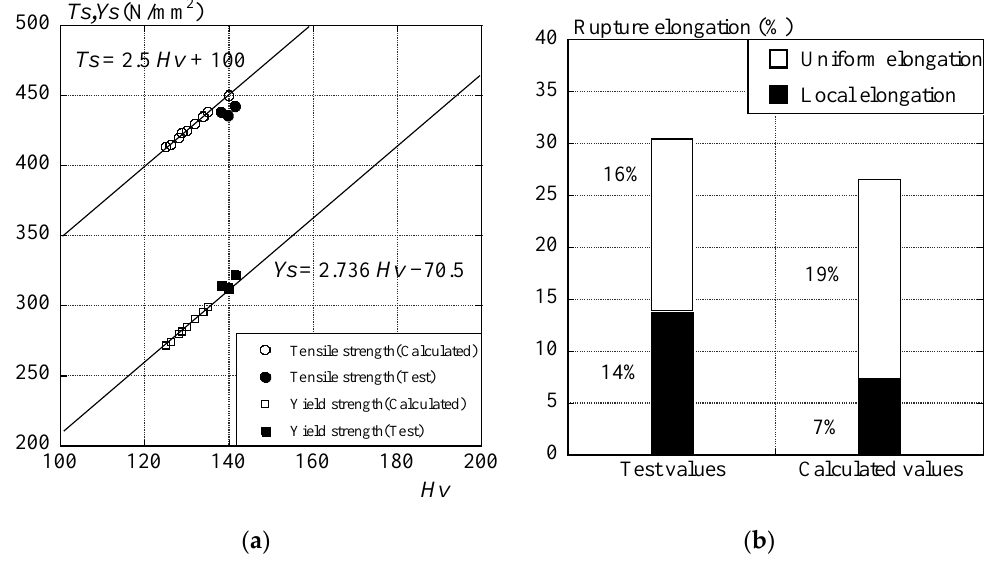
Figure 7. ( a ) Tensile strength, yield point or yield strength, and Vickers hardness and ( b ) test values and calculated values of uniform elongation and local elongation.